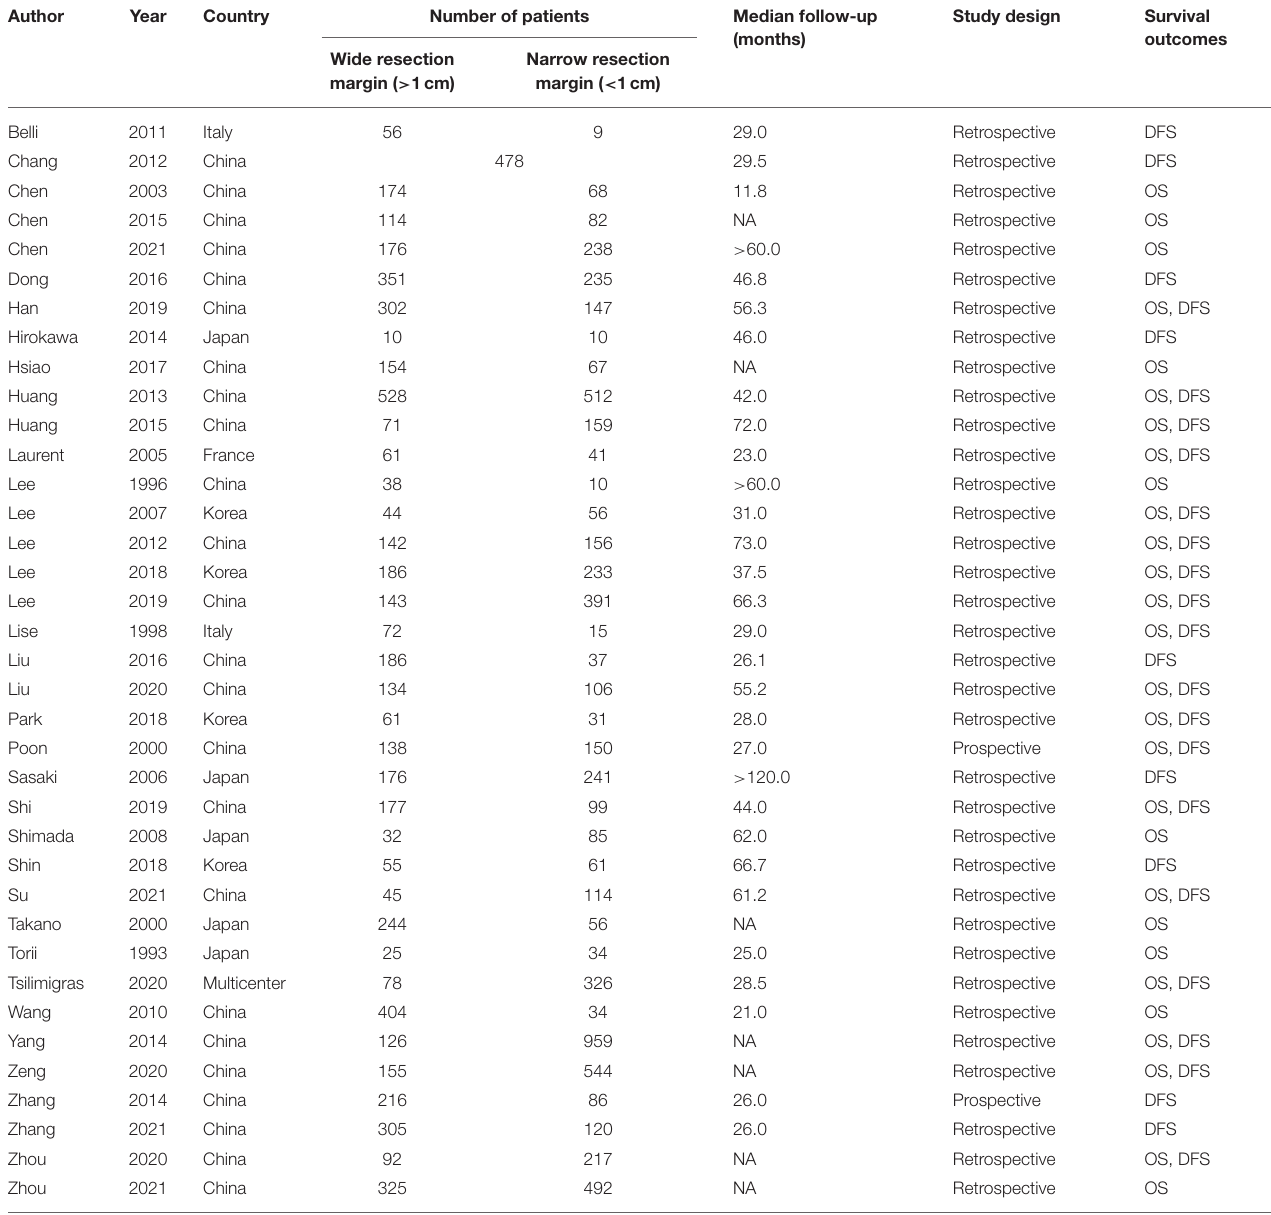
TABLE 1-1 | Characteristics of all the studies included in the